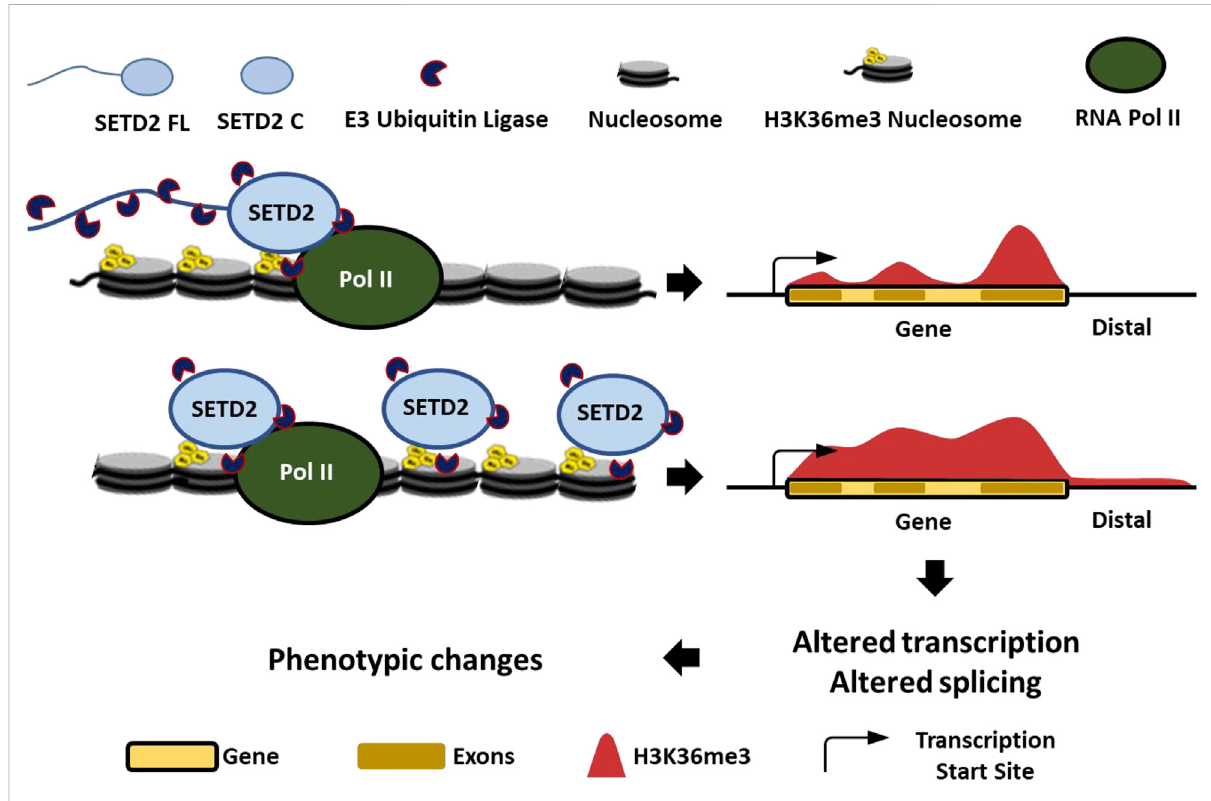
FIGURE 5 Proteolysis-mediated regulation of SETD2 levels is important to maintain its appropriate